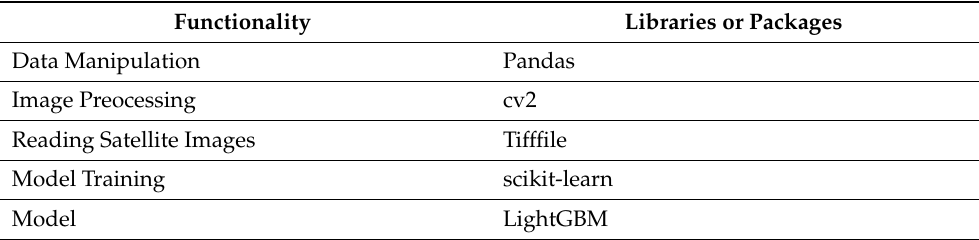
Table 12. Python libraries or packages used in this study .